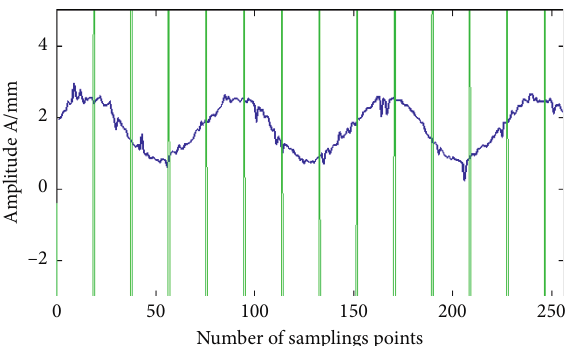
Figure 7: Time-domain waveform of the acquisition signal.